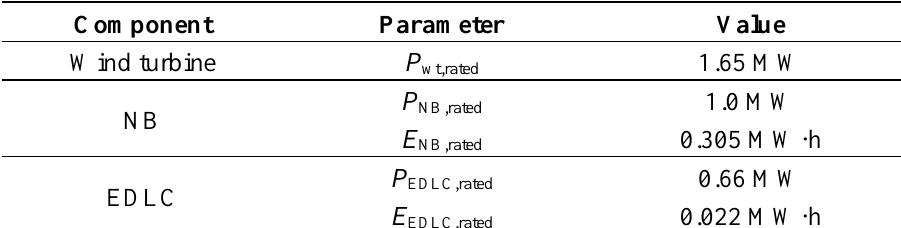
Table 3. Test system parameters.